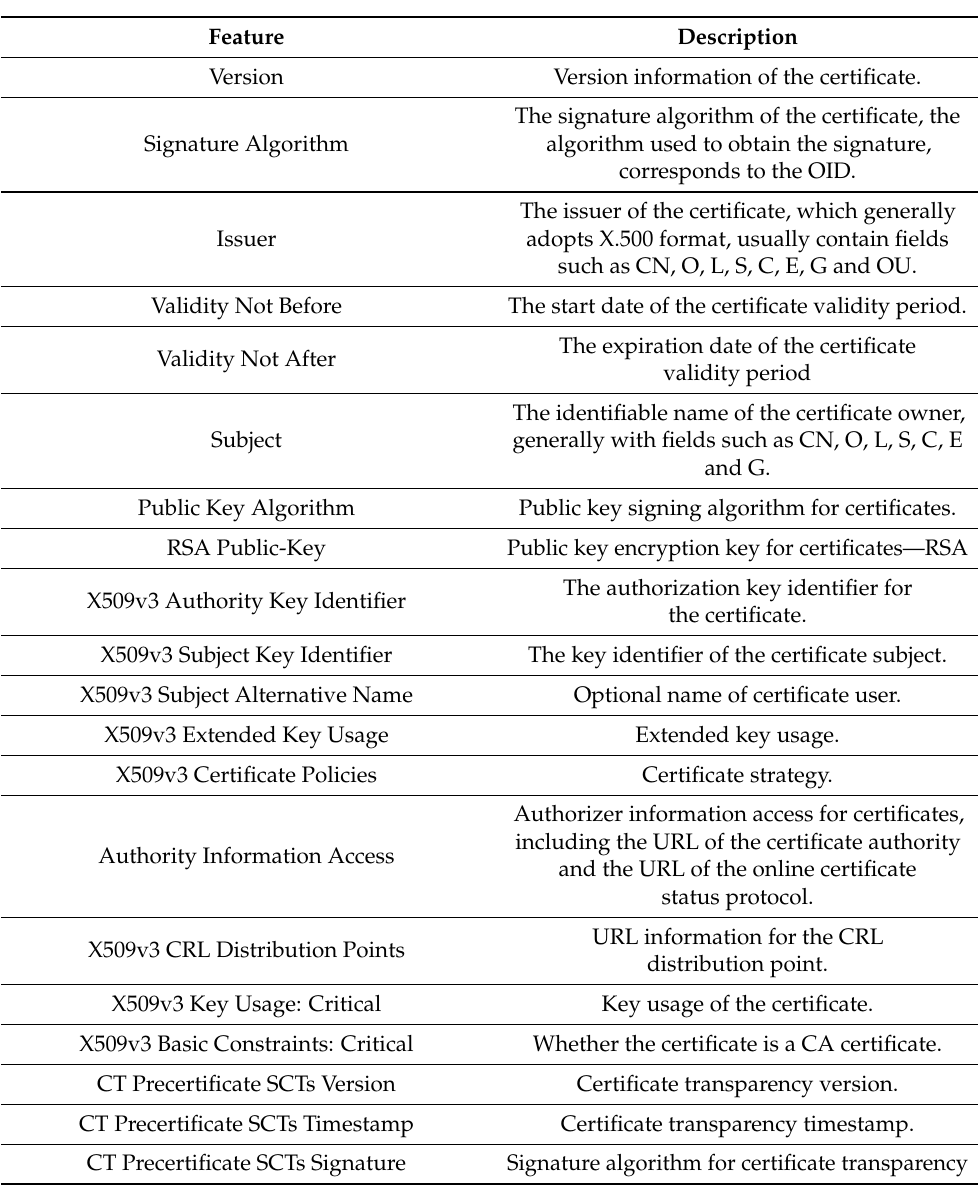
Table 2. Sample features from